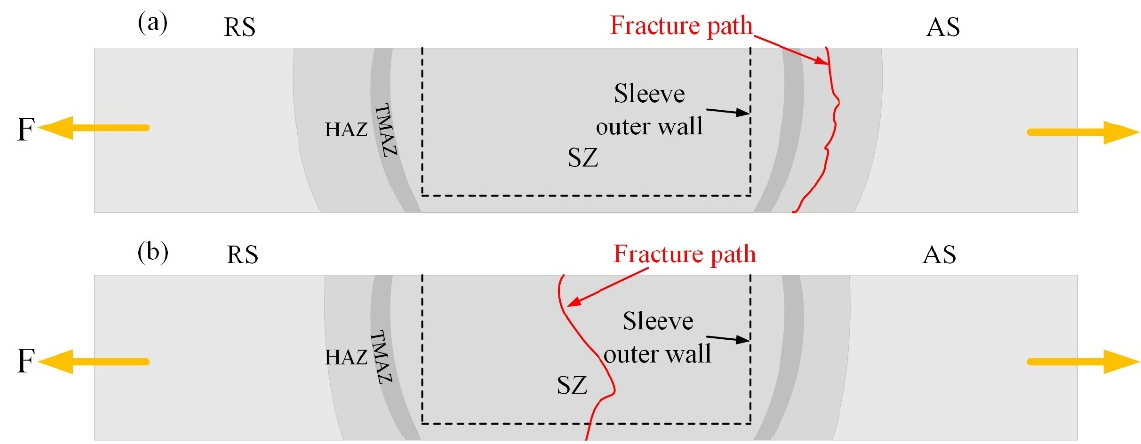
Figure 10. Schematics of the fracture paths of joints at ( a ) 110 mm/min and ( b ) 210 mm/min welding speed.